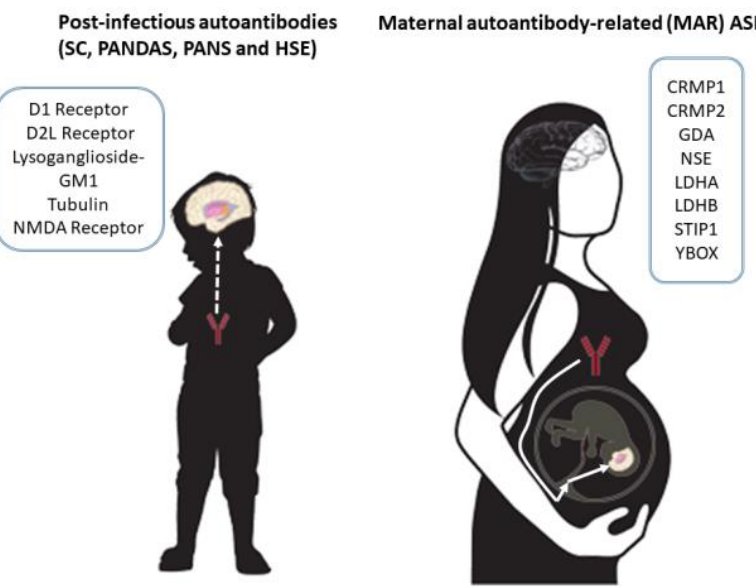
Figure 1 . Autoantibody targets in post-infectious autoimmune neuropsychiatric disorders and MAR ASD. D1R, dopamine D1 receptor; D2LR, dopamine D2L receptor; neuronal surface antigen lysoganglioside-GM1; tubulin; NMDA receptor, N-methyl-D-aspartate receptor; CRMP1/CRMP2, collapsing response mediator proteins 1 and 2; GDA, guanine deaminase, cytosolic PSD-95 interactor; NSE, neuronspecific enolase; LDHA/LDHB, lactate dehydrogenase A and B; STIP1, stress-induced phosphoprotein 1; and YBOX, Y-box binding protein